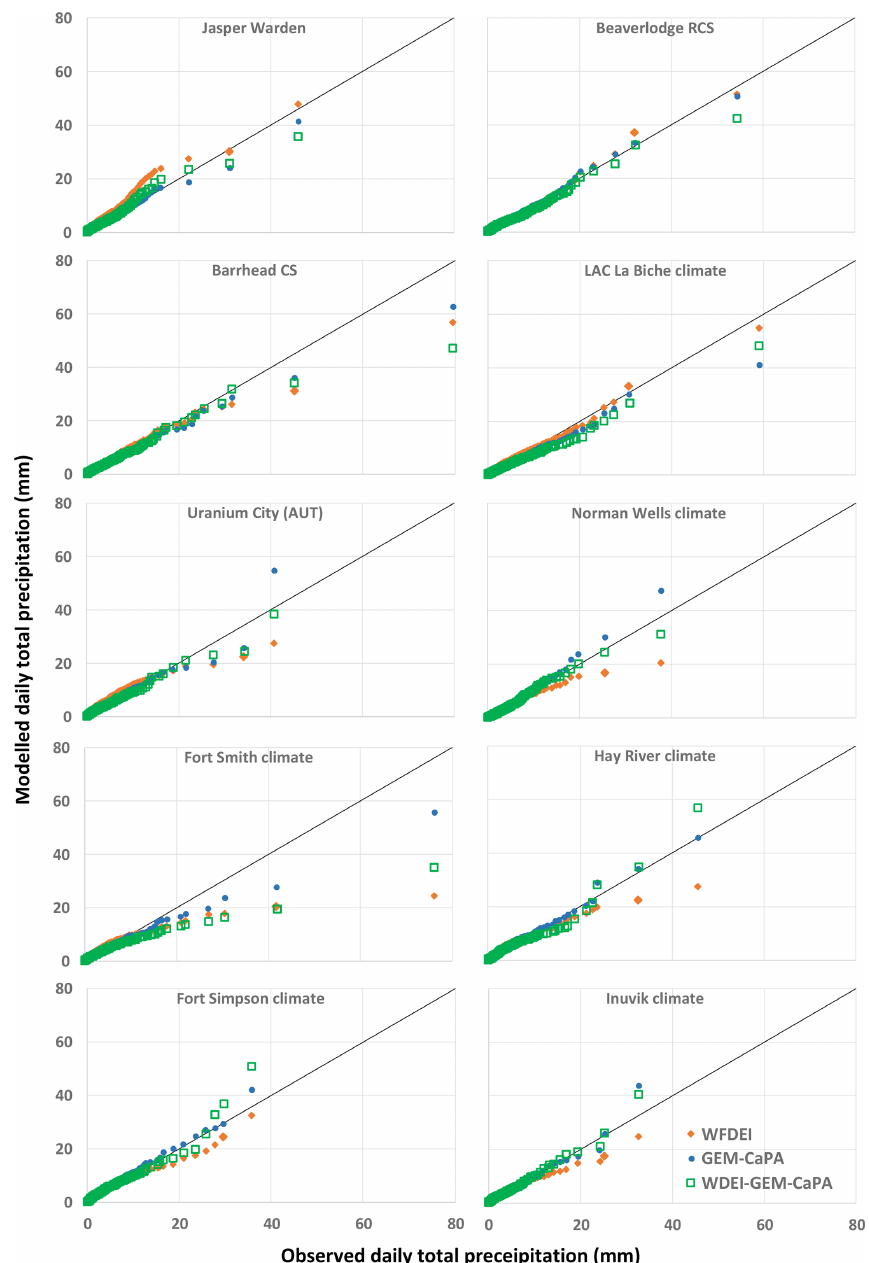
Figure 6. Quantile–quantile plots of modelled (GEM-CaPA, WFDEI, and WFDEI-GEM-CaPA) and observed (ECCC-S) daily total precip-